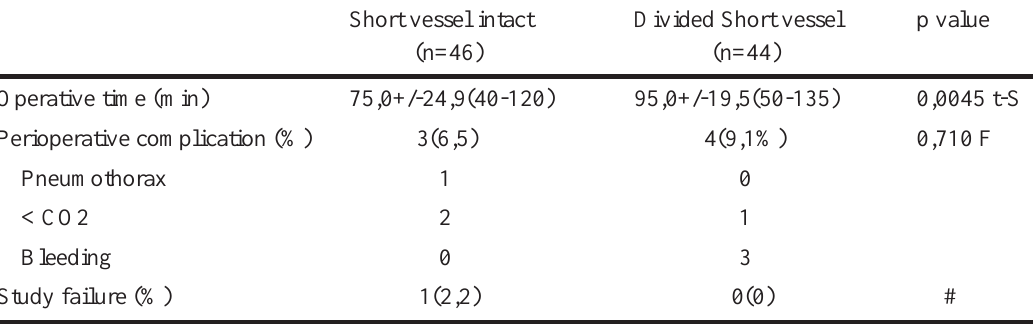
TABLE 2 - Perioperative course